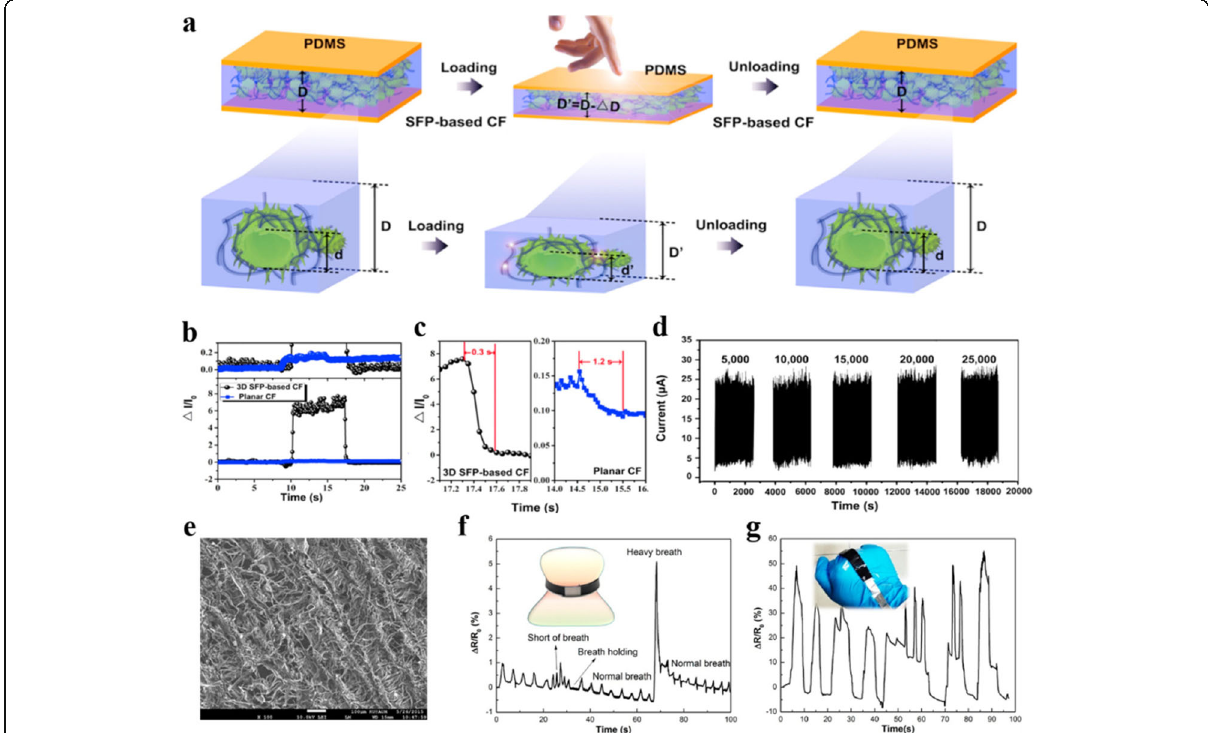
Fig. 3 a Schematic of the mechanism of the sensor with hollow-sphere structure induced by sunflower pollen microcapsules under pressure. b Transient response of SFP-based composite film (CF) and planar CF under 600Pa pressure. c Relaxation time of the two related sensors. d Stability test of SFP-based CF at 80 Pa. Adapted with permission from ref. 3. Copyright 2017 Elsevier. e The SEM image of the converted carbon paper. f , g Monitoring the breath ( f ) and gesture ( g ) of an adult by the CP/PDMS sensor. Adapted with permission from ref. 63. Copyright 2017 American Chemical